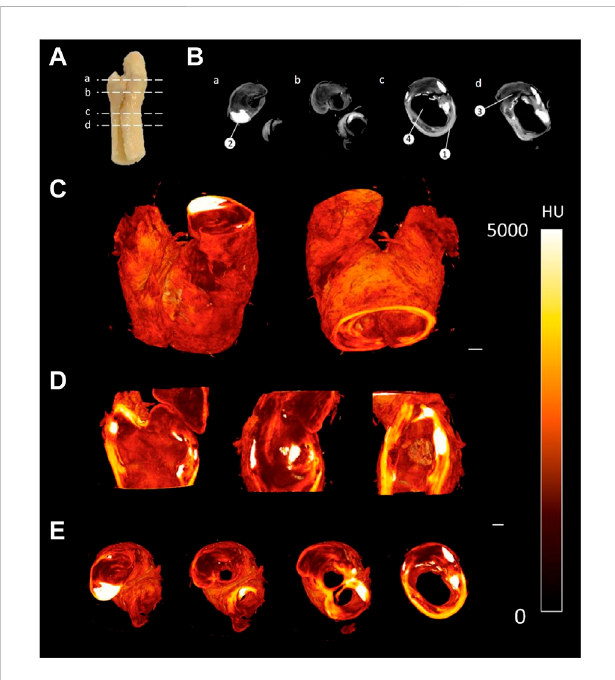
FIGURE 5 CEµCT of human atherosclerotic plaque (A) Slice locations in atherosclerotic plaque. (B) Axial cross-sections directly from MicroCT show multiple components within thetissue: (1) Outer wall ofplaque, (2) Calci fi cation, (3) Lipid, and (4) Lumen of plaque. (C) 3D render of atherosclerotic plaque. (D) Sagittal and coronal cross-sections through atherosclerotic plaque. (E) Axial cross-sections through atherosclerotic plaque. Scale bar = 1